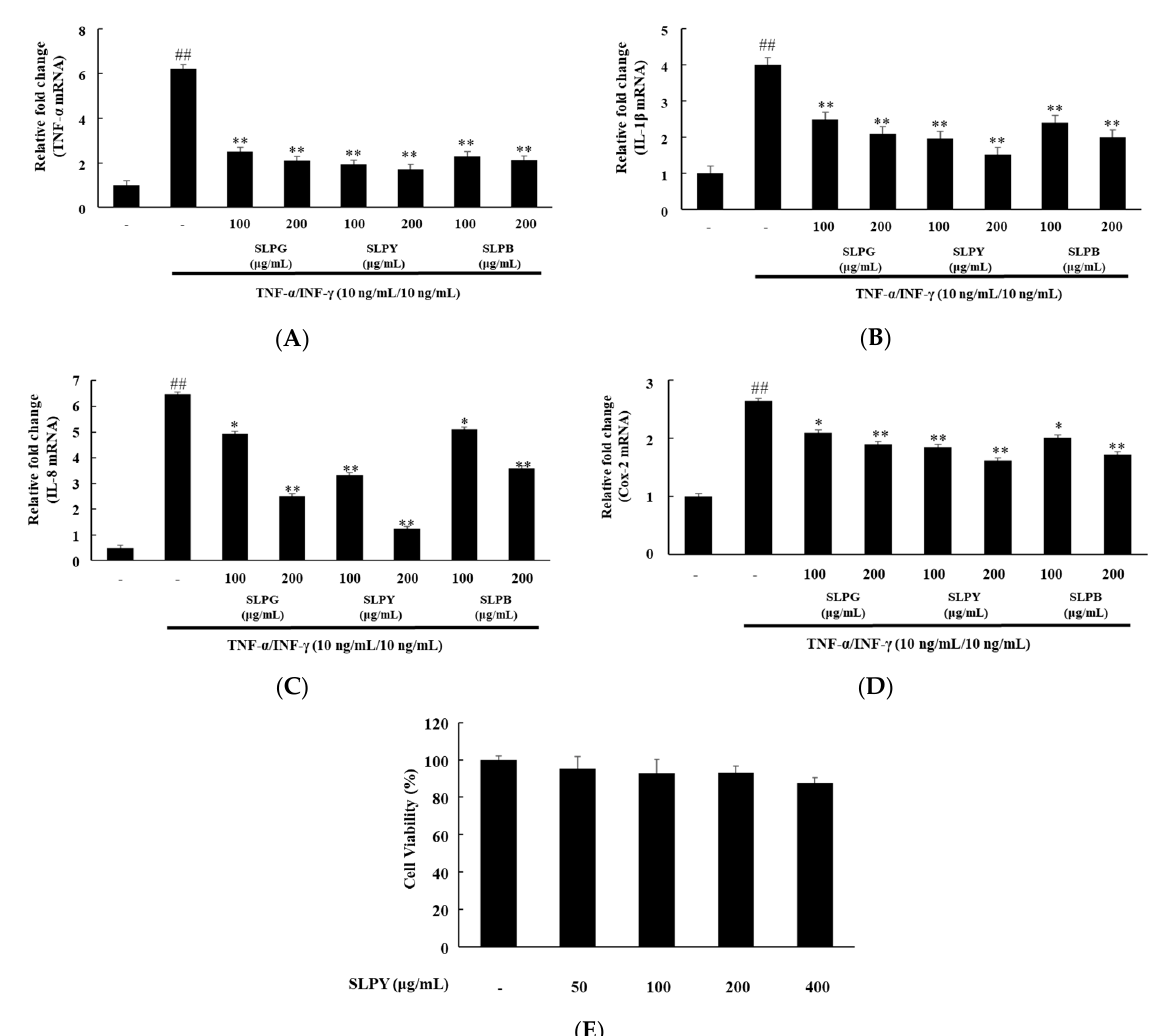
Figure 1. Effect of different silkworm by-products on levels of inflammatory cytokine expression in HaCaT cells. ( A ) TNF- α , ( B ) IL-1 β , ( C ) IL-8, and ( D ) Cox-2 mRNA expression in HaCaT cells treated with SLPG, SLPY, and SLPB at 100 and 200 µ g/mL concentrations, followed by TNF- α (10 ng/mL)/INF- γ (10 ng/mL) co-treatment for 6 h. ( E ) Percentage of HaCaT cell viability measured using MTT assay. Following the treatment with SLPY for 24 h, the viability of HaCaT cells was compared with that of the control (100%). Values represent the mean ± SD of three replicates of viable cell percentage compared to the control. ## p < 0.01 vs. the corresponding control group and ** p < 0.01, * p < 0.05 vs. the corresponding TNF- α /INF- γ treated group. TNF: tumor necrosis factor; IL: interleukin; Cox-2: cyclooxygenase-2; SLPG: steamed and freeze-dried powdered by-product of mature silkworm larvae of the Golden Silk strain; SLPY: steamed and freeze-dried powdered by-product of mature silkworm larvae of the Yeonnokjam strain; SLPB: steamed and freeze-dried powdered by-product of mature silkworm larvae of the Baekokjam